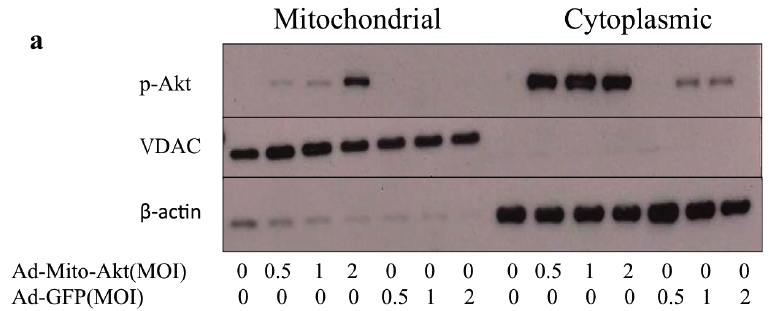
Figure 3. Effect of overexpressed mitochondrial Akt on RPE cell migration ( a ) The Western blot showed that Ad-Mito-Akt virus can overexpress mitochondrial phospho-Akt in RPE cells. Different multiplicity of infection (MOI), the ratio of virus to RPE cells, of Ad-Mito-Akt and Ad-GFP viruses were used to transduce RPE cells. As the MOI of Ad-Mito-Akt increased, phospho-Akt in the mitochondrial compartment increased. No phospho-Akt activity in the mitochondrial fraction was detected in Ad-GFP transduced RPE cells; ( b ) Transwell migration assay. The migration activity of Ad-Mito-Akt transduced RPE cells increased when compared with Ad-GFP transduced RPE cells. The increased migration activity of RPE cells transduced with Ad-Mito-Akt was inhibited by lutein in the concentration of 10 μ M; ( c ) The bar graph showed the cell count of migrated RPE cells treated with or without PDGF, lutein, and with or without transduction using Ad-Mito-Akt or Ad-GFP. Data are expressed in mean ± SD of 5 independent experiments. * p < 0.001 vs. control; # p < 0.001 vs. PDGF 20 mg/dL and lutein 0 μ M; @ p < 0.001 vs. Akt with MOI 1; & p < 0.001 vs. GFP with MOI 1; % p < 0.05 vs.